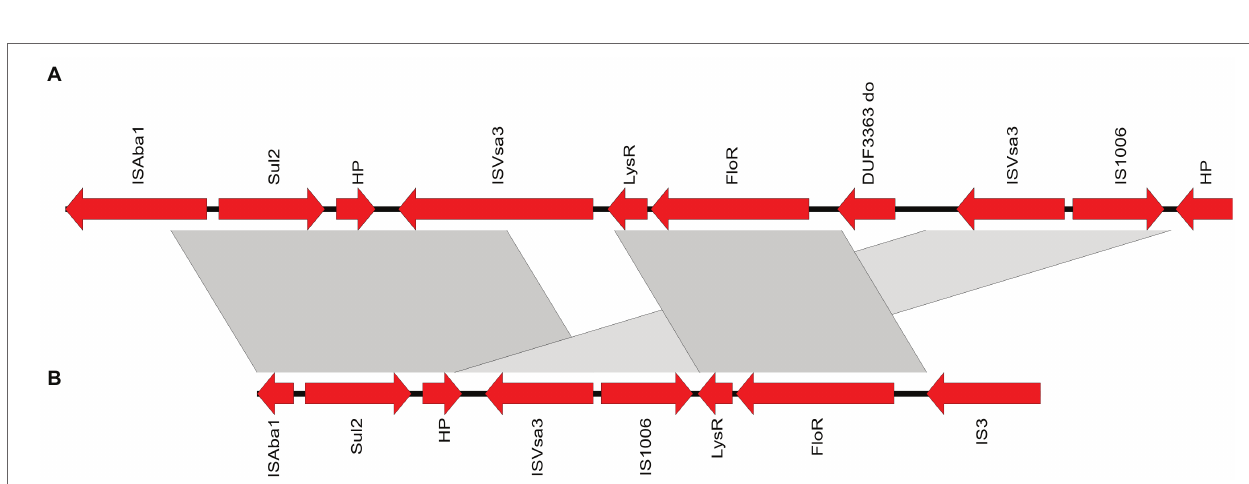
FIGURE 6 | Depiction of the genetic structure containing the genes sul2 and floR identified in strain M11 (A) compared to Acinetobacter indicus strain GXNN62X4 chromosome, GenBank accession: CP071319 (B) . ORFs orientation is indicated by arrows. Grey bands between panels indicate more than 98% sequence similarity. Genes are labelled by their protein products; LysR, LysR family transcriptional